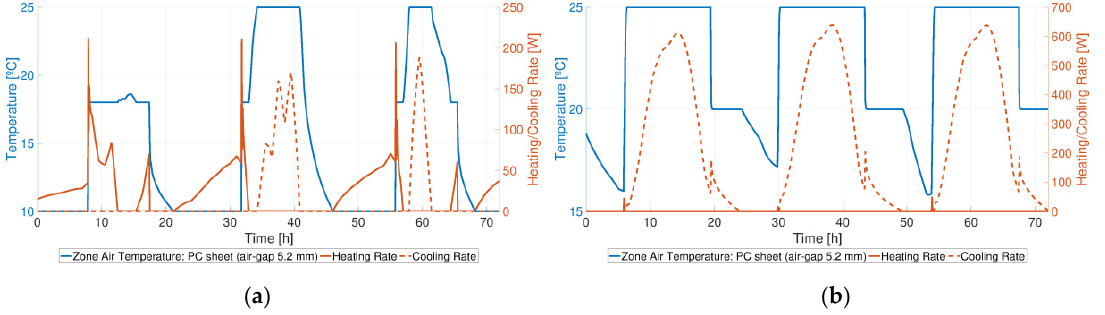
Table 2. Scenarios for the geometry and non-geometry parameters of the greenhouse.